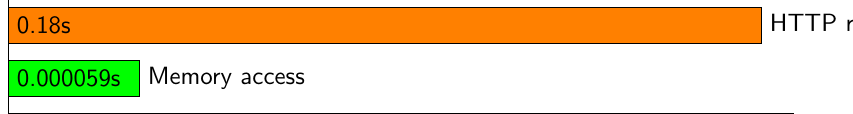
Figure 8. Time difference between HTTP request and